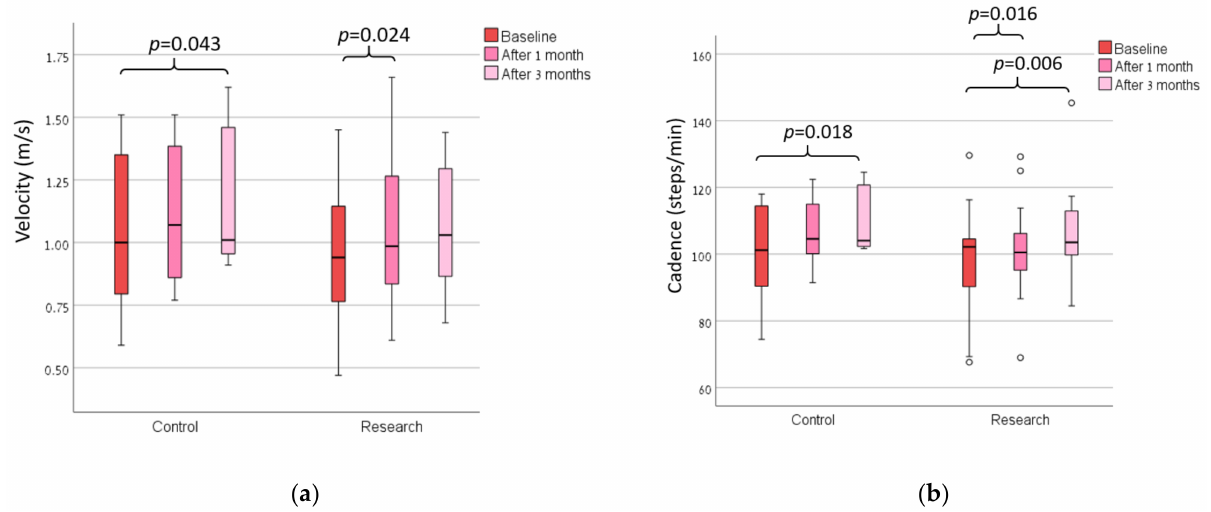
Figure 4. The ( a ) gait velocity and ( b ) cadence of both groups at baseline, 1 month and 3 months after the